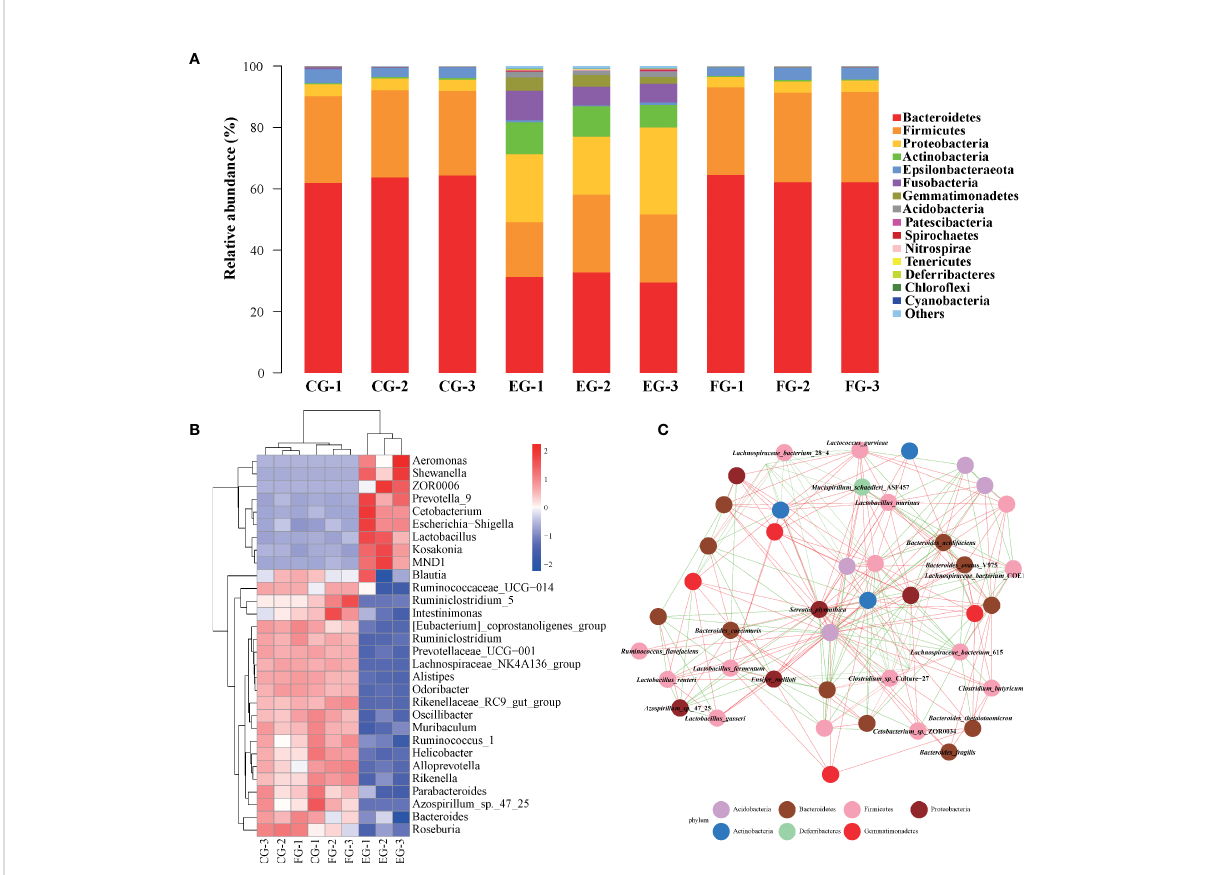
FIGURE 3 Major dominant and specialized targets of bacterial communities in different antibiotic-treated groups. (A) Relative taxonomic abundance of bacterial communities at the phylum level found in different groups. (B) Heatmap of relative abundances of the 30 most dominant genera summarized in the midgut microbial communities from three different groups. (C) Co-occurring species network according to correlation analysis using top 50 species with Spearman coef fi cient > 0.7 and p value < 0.01. Red and green edges represent positive and negative correlations, respectively. The phylum taxonomy is marked through the node